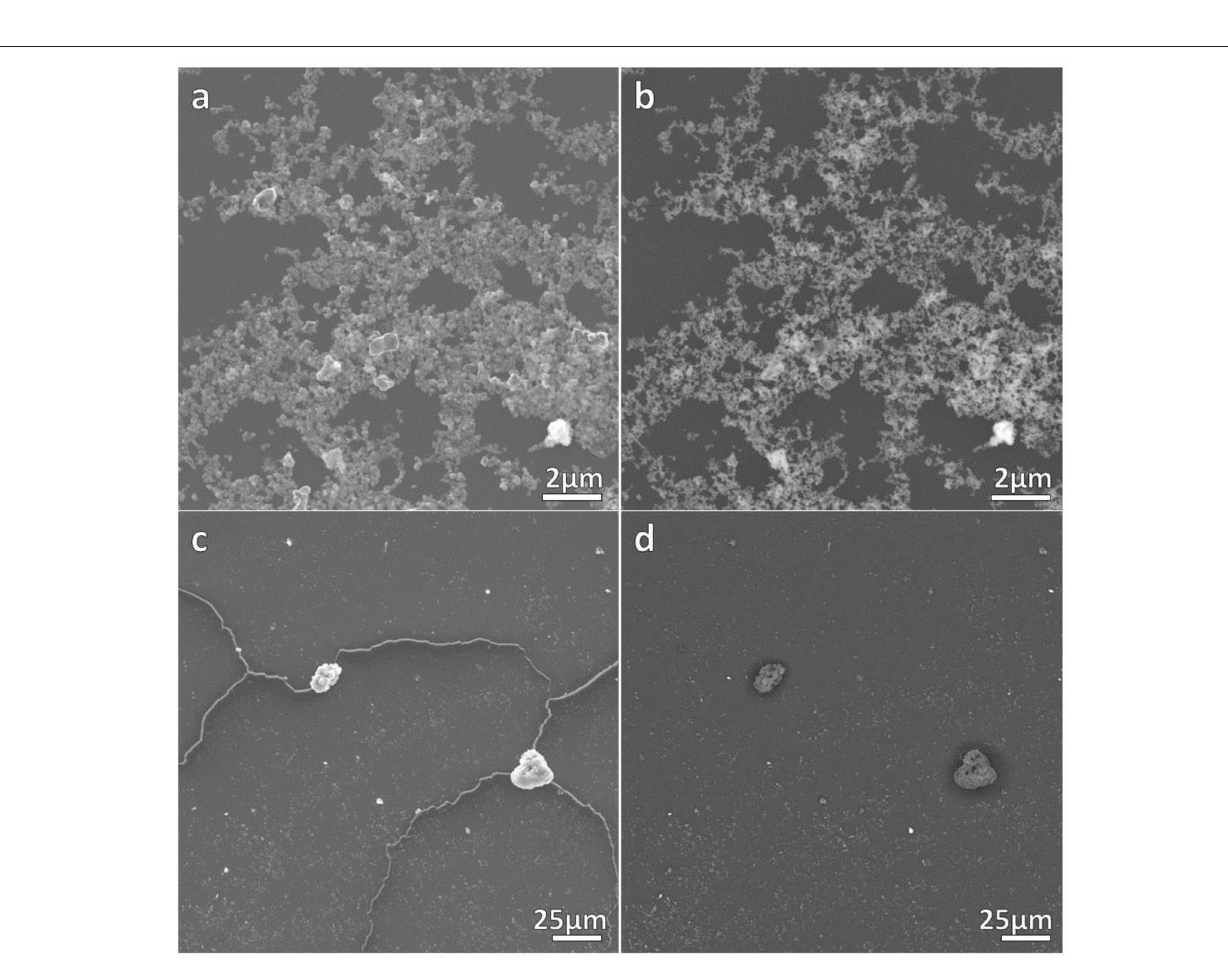
Frontiers in Chemistry |